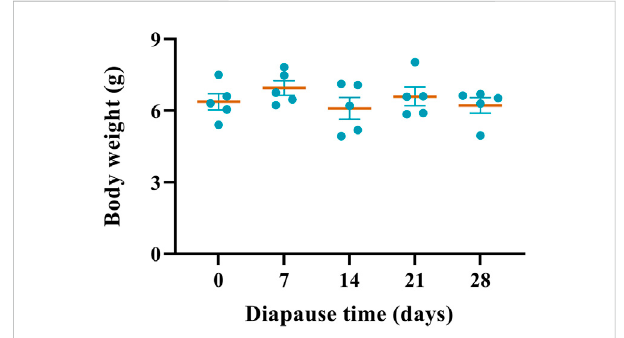
FIGURE 1 Effect of diapause time on the body weight of diapause C. bilineata tsingtauica larvae. Data are mean ± SEM.